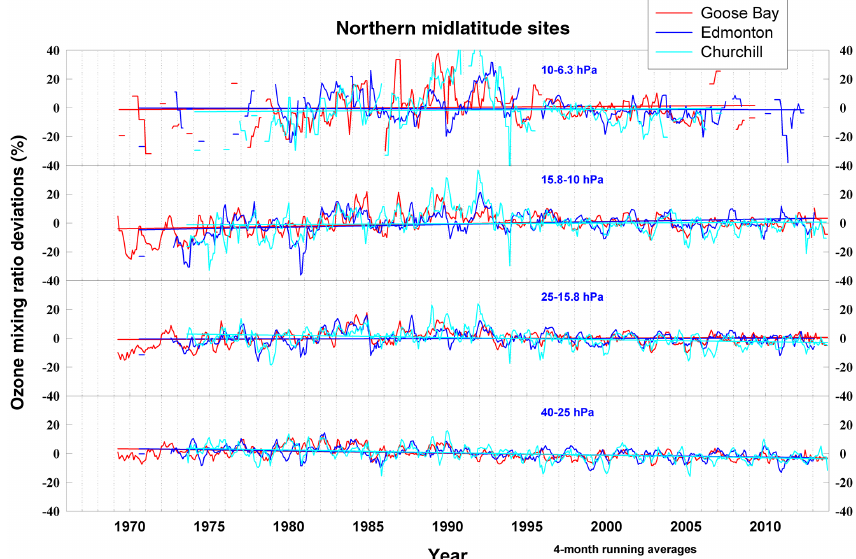
Figure 13. Percent deviations in average ozone mixing ratio for four middle stratospheric layers, using data from three midlatitude stations. Monthly anomalies have been smoothed with a 4-month running average. The overall station trend lines are shown.